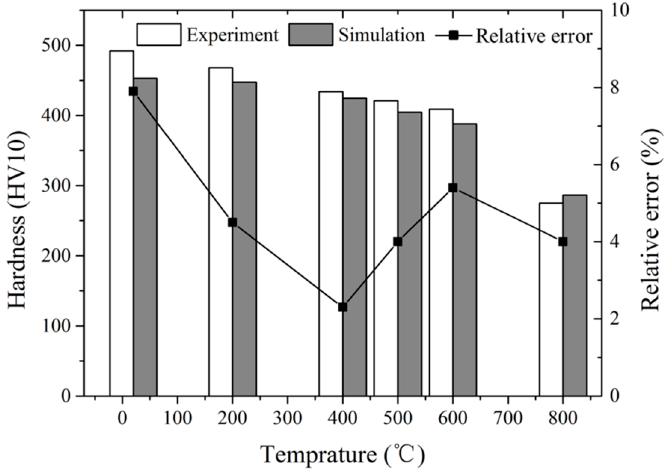
Figure 12. Comparison of simulation and experiment results.